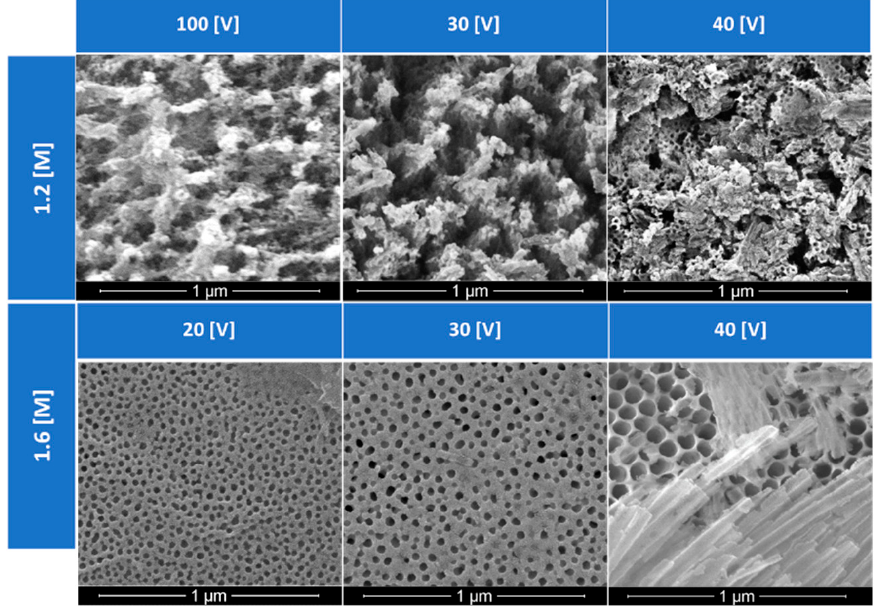
Figure 5. Effects of concentration and anodization voltage in the pore structure generated in the anodized aluminum.